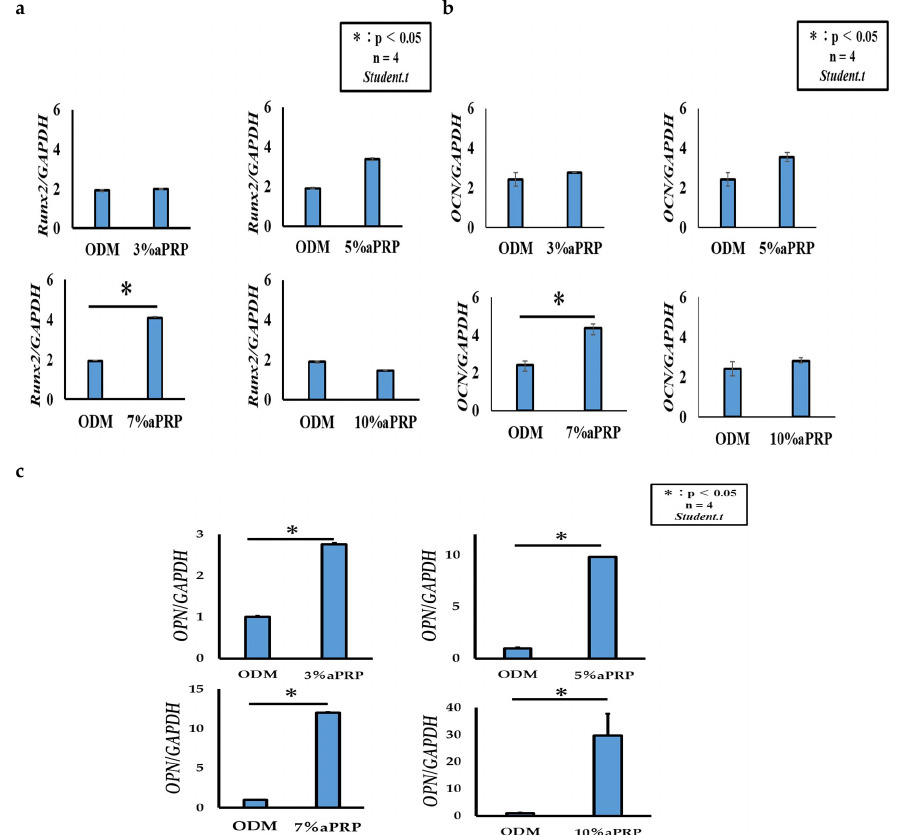
Figure 10. Gene expression of Runt-related transcription factor 2 ( Runx2) , osteocalcin ( OCN), and osteopontin ( OPN) during dedifferentiation of rat dedifferentiated fat cells. ( a ) The expression level of Runx2: osteoblast induction day 3. ( b , c ) The expression level of OCN , OPN: osteoblast induction